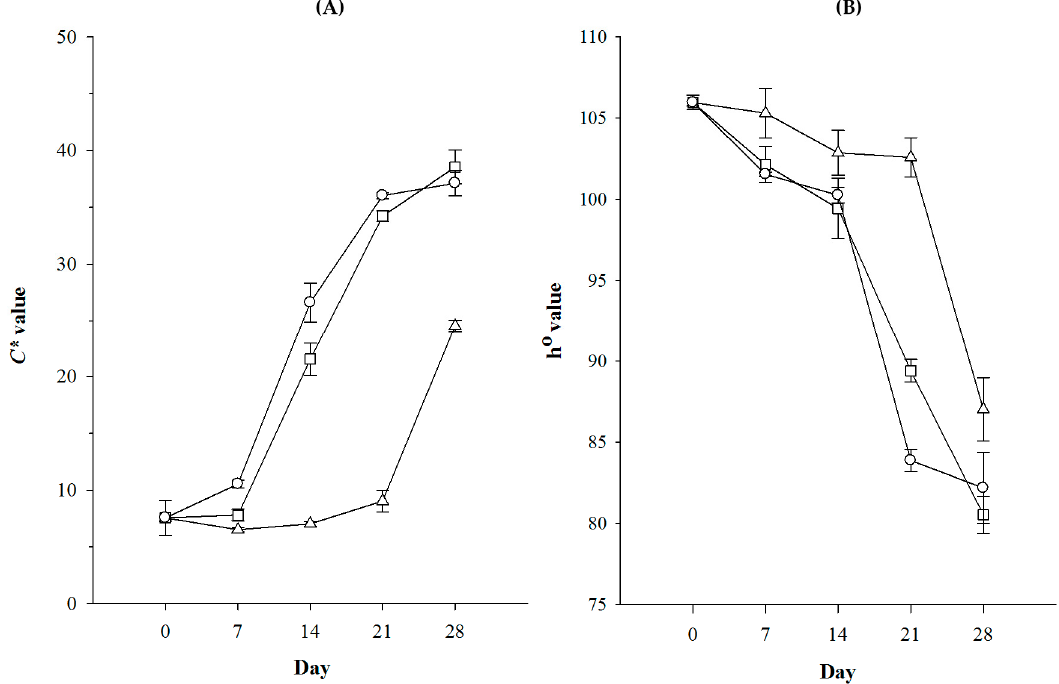
Figure 3. Changes in color saturations ( A ) and hues ( B ) of Arthrobacter arilaitensis Po102 cultures during growth on different deacidified cheese-based solid media at initial pH 5.8 without adding NaCl. ∆ = CM NaOH , □ = CM Dh304 , and ○ = CM Km44 .